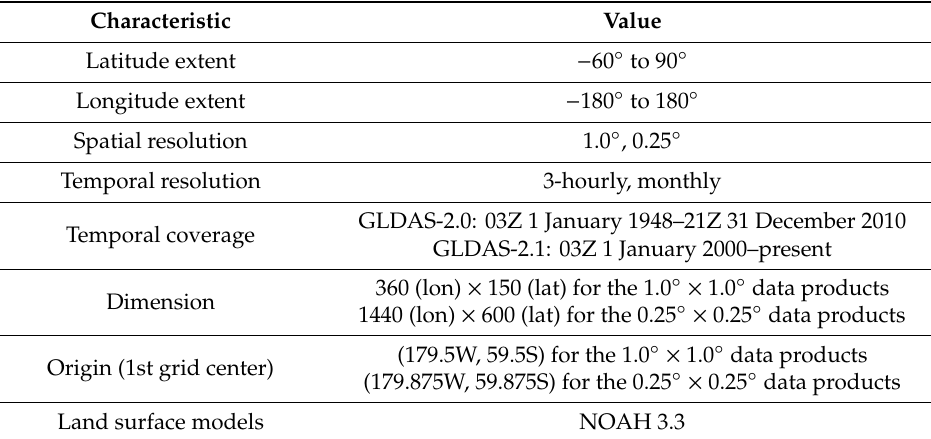
Table 1. Basic description of Global Land Data Assimilation System (GLDAS)-2